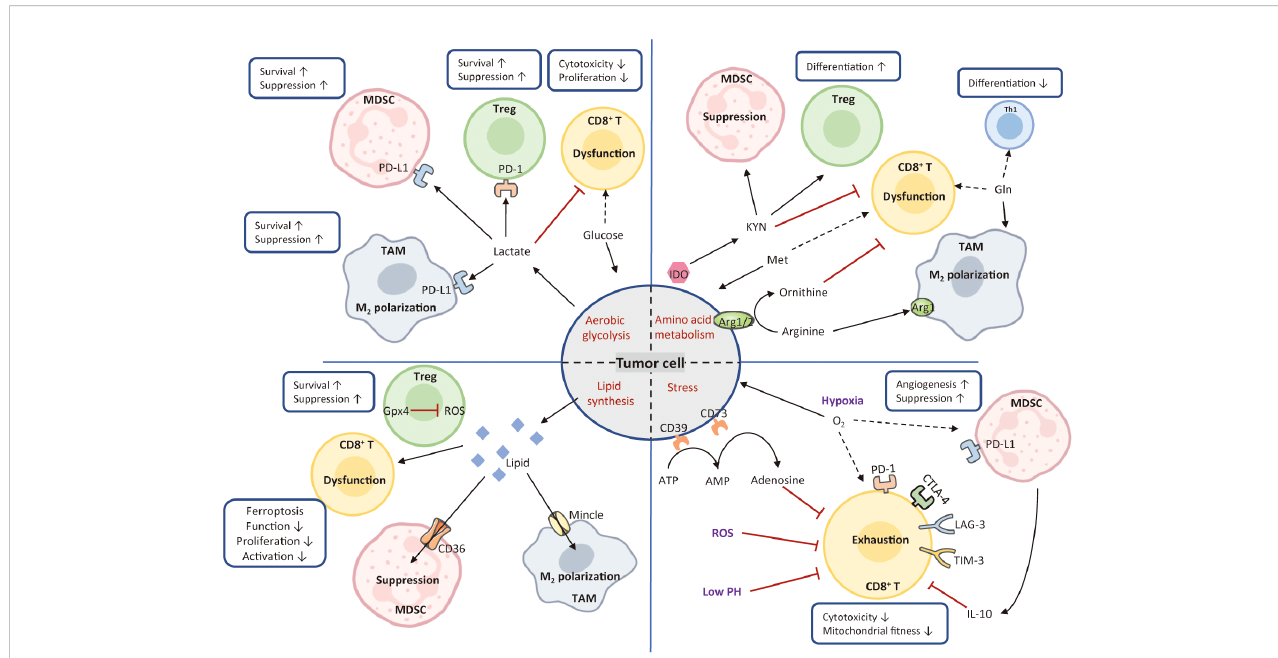
FIGURE 4 Mechanisms of metabolism-mediated immune escape. In the TME, hypermetabolic tumor cells interfere with immune cell function by depriving nutrients and produce various types of metabolic stress. Tumor cells utilize large amounts of glucose and amino acids to fuel their glycolysis and amino acid metabolism. These activities greatly limit nutrient availability to T cells, leading to the formation of immunosuppressive TME. Tumor cells also release excessive lipids into the TME, resulting in the enhanced lipid metabolism, high oxidative stress, and T-cell dysfunction. Conversely, Treg cells express high levels of glutathione peroxidase 4, avoiding ROS accumulation and the induction of ferroptosis. Cancer metabolism produces various metabolic stimuli, including hypoxia, low PH, and ROS, all of which impede CD8 + cytotoxicity and fi tness. The solid black arrows present that the majority of nutrients are consumed by the cells, whereas the dashed black arrows indicate a paucity of molecule available to the cells. The red arrows represent inhibited metabolic pathways. MDSC, myeloid-derived suppressor cell; Treg, regulatory T; TAM, tumor-associated macrophage; Th1, T helper 1; IDO, indoleamine 2, 3-dioxygenase; Arg1, arginase; ROS, reactive oxygen species; KYN, kynurenine; Met, methionine; Gln, glutamine; Gpx4, glutathione peroxidase